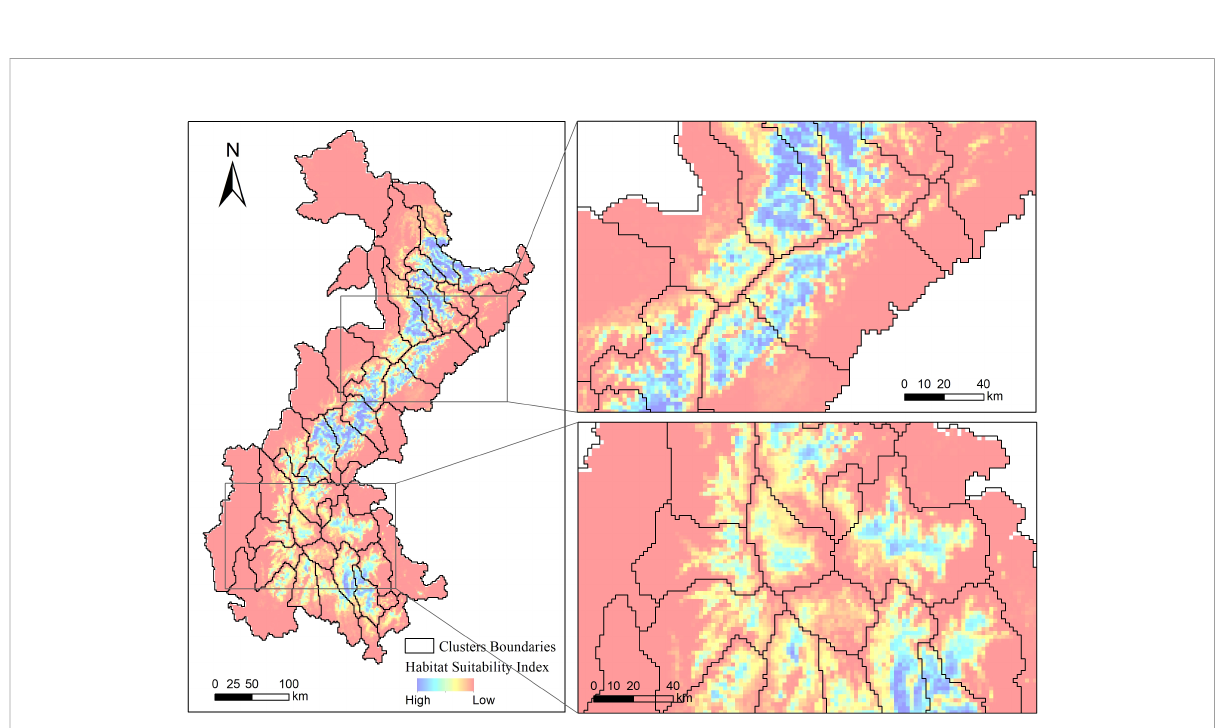
FIGURE 4 The boundaries of giant panda habitat clusters (black polygons) delineated from the Louvain algorithm are shown against the habitat suitability index map (colors from red to blue indicating from less to more suitable habitats).